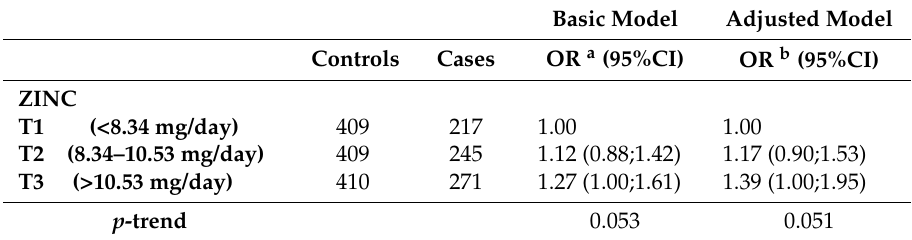
Table 2. Dietary zinc and prostate cancer risk in MCC-Spain case control study. Basic Model Adjusted